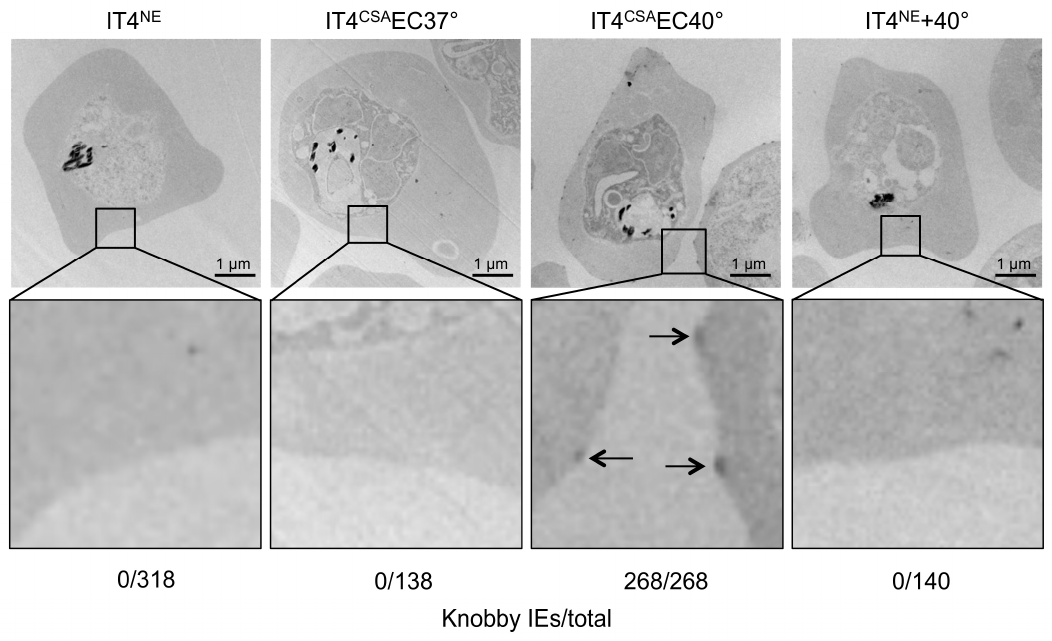
Figure 3. Knob formation of IT4 populations enriched for binding to HBEC-5i cells at 37 ◦ C and 40 ◦ C. Electron micrographs of erythrocytes infected with IT4 NE , IT4 CSA EC37 ◦ , IT4 CSA EC40 ◦ , and IT4 NE heat-shocked at 40 ◦ C for 2 h weekly over a period of 5 weeks. Arrows indicate knobs.